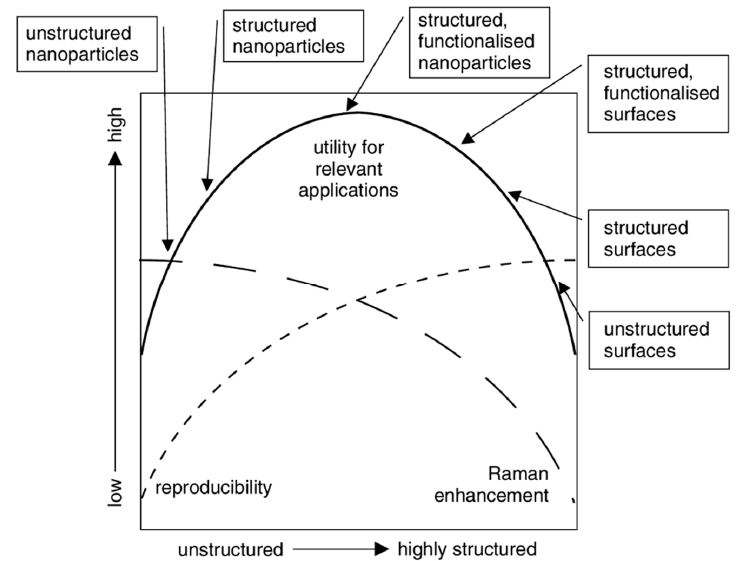
Figure 21. The reproducibility/uniformity and the Raman enhancement for a large number of substrates (Y axis) is correlated to the degree of order ( X axis). The reproducibility/uniformity (short dashed line) increases with the degree or order of the substrate, while the enhancement (long dashed line) follows the opposite trend. For relevant applications, SERS substrates have to satisfy a tradeoff between the former and the latter. Reproduced with permission from Milton et al. [303]. Copyright (2008), John Wiley and Sons.